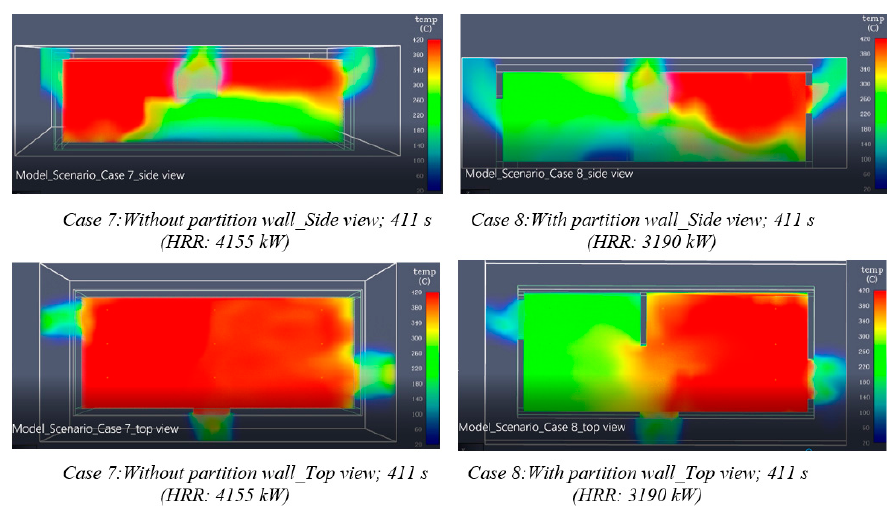
Figure 9. Temperature and HRR difference with the same ventilation condition and different geometry for cases 7 and 8. In case 8, the partition wall increased the heterogeneity of the enclosure temperature and reduced temperature and the possibility of a flashover/backdraft (Figures 8b and 9). In cases with a partition wall, the temperature was lower, and the heterogeneity increased (Figure 10).